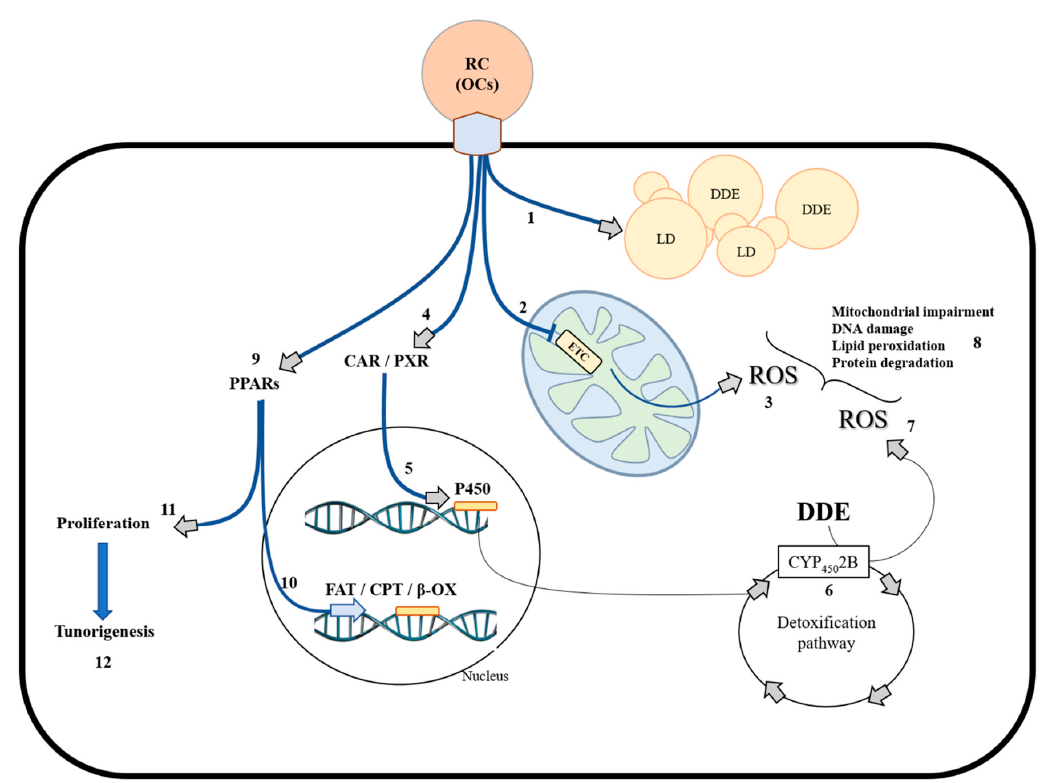
Figure 2. Principal mechanisms stimulated by organochlorinated compounds. Organochlorinated compounds (OCs), including DDE accumulated in contaminated foods, reach the liver from the blood vessels by remnant chylomicrons. In the cells, OCs can be, in part, stored in the lipid droplets (1). In addition, OCs can act on mitochondria, partially inhibiting the electron transport chain (2) and inducing mitochondrial ROS production (3). Moreover, OCs such as DDE can interact with CAR and PXR receptors (4), inducing expression of the P450 gene family (5) for detoxification (6). However, the detoxification path augments ROS levels (7). These mechanisms, if not e ff ectively controlled by antioxidant defenses, produce oxidative damage in macromolecules (8). In addition, OCs can modulate transcriptional activity through PPAR family members (9), modulating fatty acid metabolism (10) and cellular proliferation (11). Uncontrolled proliferative mechanisms induced by OCs can lead to tumorigenesis (12). RC: remnant chylomicrons; OCs: organochlorinated compounds; DDE: Dichlorodiphenyldichloroethylene; LD: lipid droplets; ETC: electron transport chain; CAR: constitutive androstane receptor; PXR: pregnane X receptor; PPARs: peroxisome proliferator-activated receptors; FAT: fatty acid transporters; CPT: carnitine palmitoyl-transferase; β -OX: beta oxidation; P450: cytochrome P450; ROS: reactive oxygen